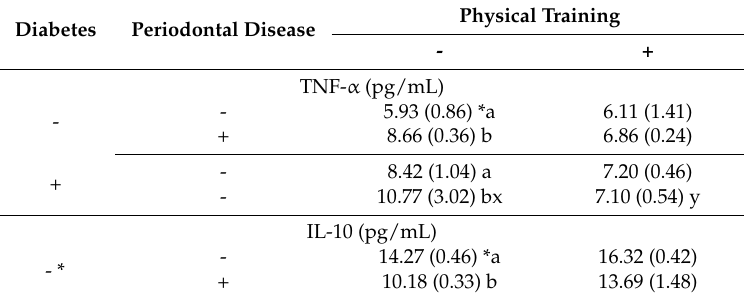
Figure 2. Alveolar Bone Loss (ABL) in trained or non-trained diabetic and non-diabetic rats submitted or not to ligature induction of periodontal disease and groups: ( A )—non-trained animals without DM or PD. ( B )—non-trained animals with PD. ( C )—trained animals without DM or PD. ( D )—trained animals with PD. ( E )—type 2 diabetic (HFD/STZ) animals. ( F )—type 2 diabetic (HFD/STZ) animals with PD. ( G )—type 2 diabetes (HFD/STZ) trained animals. ( H )—trained animals with type 2 diabetes (HFD/STZ) and PD. Table 5. Circulating cytokines (TNF- α and IL10), TNF- α /IL10 and IL10/TNF- α ratio in type 2 diabetic rats (HFD/STZ) with ligature-induced periodontal disease submitted to eight weeks of physical training.